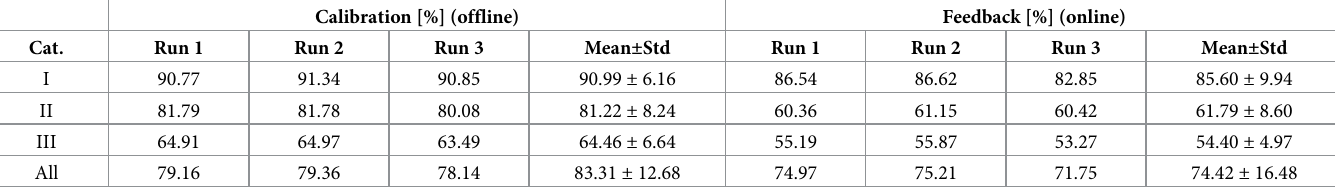
Table 4. Offline calibration accuracy and feedback performance.